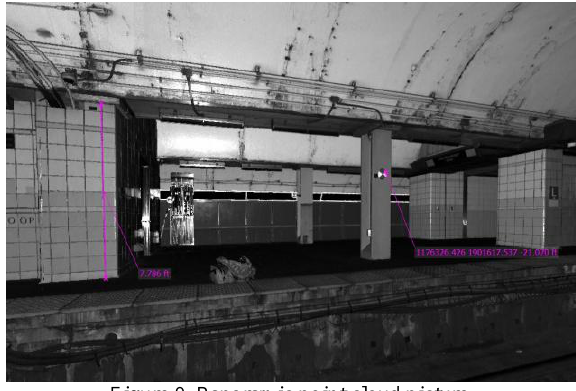
Figure 9. Panoramic point cloud picture